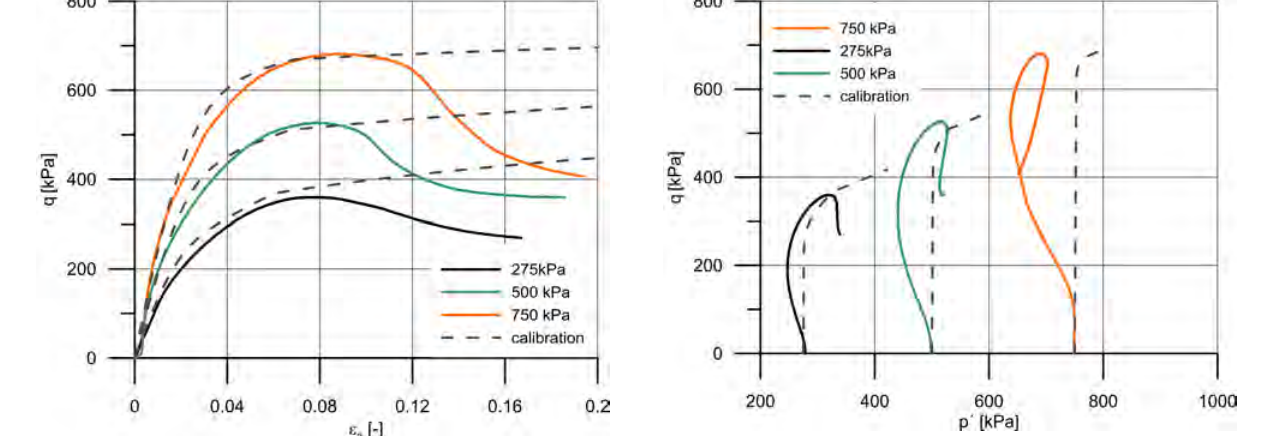
Figure 2. Triaxial stress strain curves.